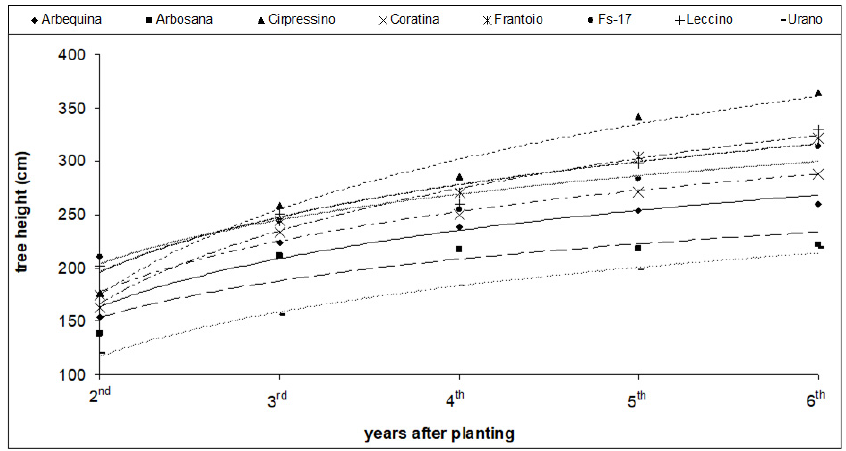
Figure 6. The von Bertalanffy functions of tree height (H, cm) for eightcultivars from second to sixth year after planting.